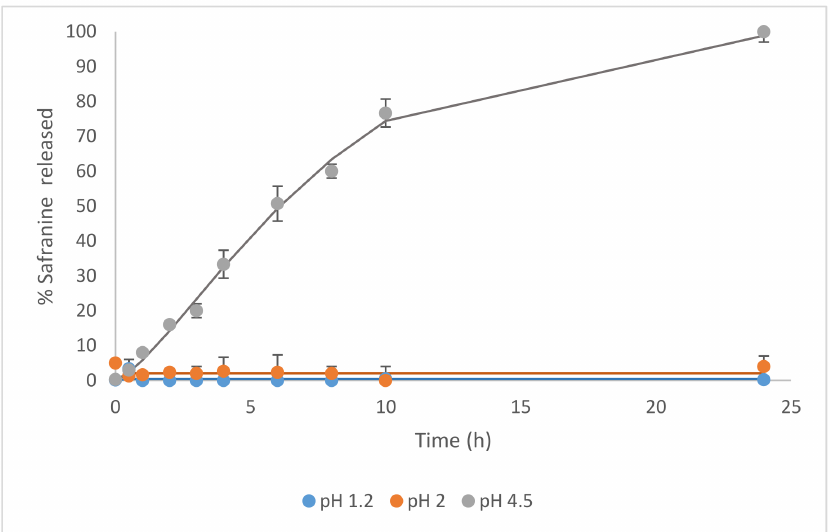
Figure 3. Safranine release profiles from a suspension of mesoporous silica microparticles, function- alized with N3 in the presence of different dissolution media at different pHs.